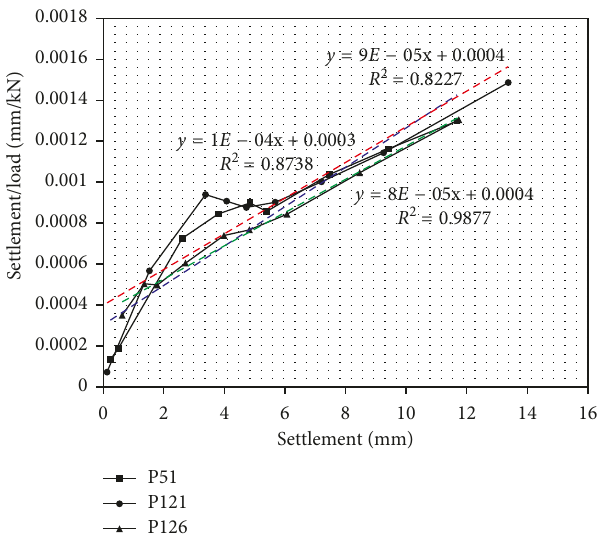
Figure 8: Results based on Chin’s